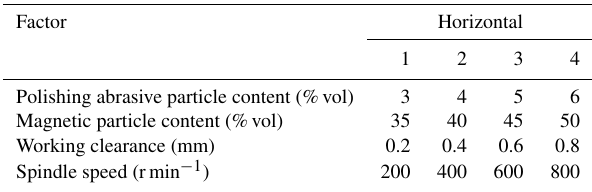
Table 5. Parameter table of experimental factors. Factor